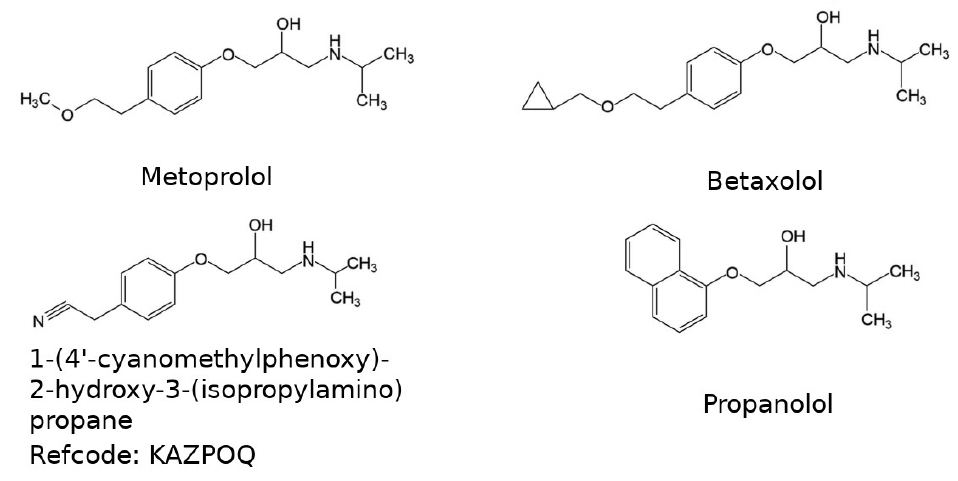
Scheme 1. Drawings of the molecules used in this study